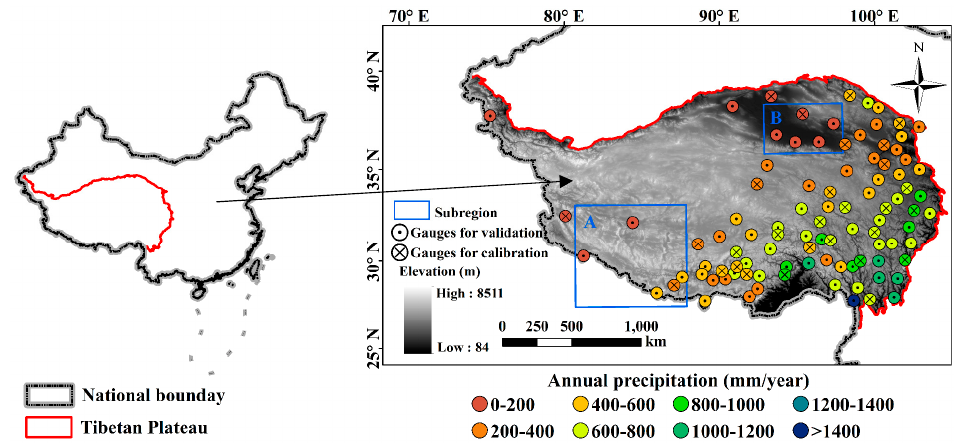
Figure 1. Distributions of rain gauges for validation and calibration over the Tibetan Plateau (TP).